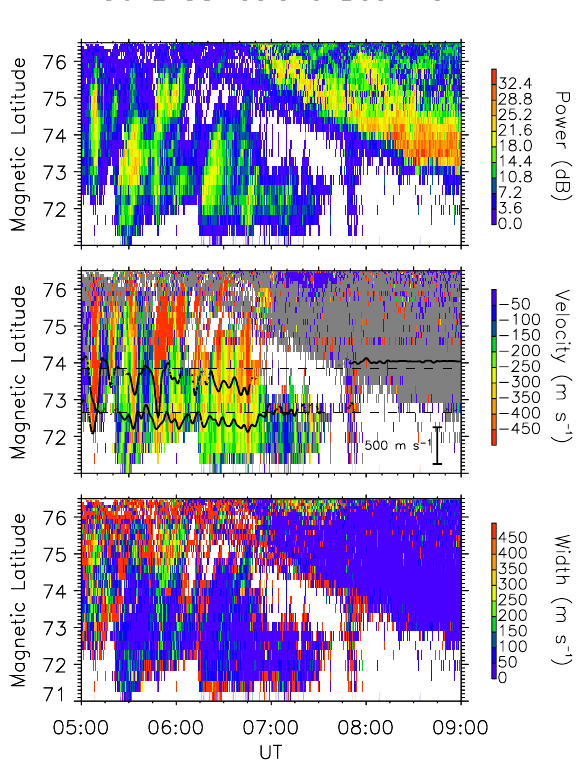
Fig. 6. Backscattered power, Doppler line-of-sight velocity and Doppler spectral width measurements from Beam 9 of the CUT- LASS Finland SuperDARN radar. Data are presented as a func- tion of magnetic latitude and universal time with each parameter colour-coded according to the scales shown on the right hand side. Transient features described in the text are highlighted by black and white dashed lines.